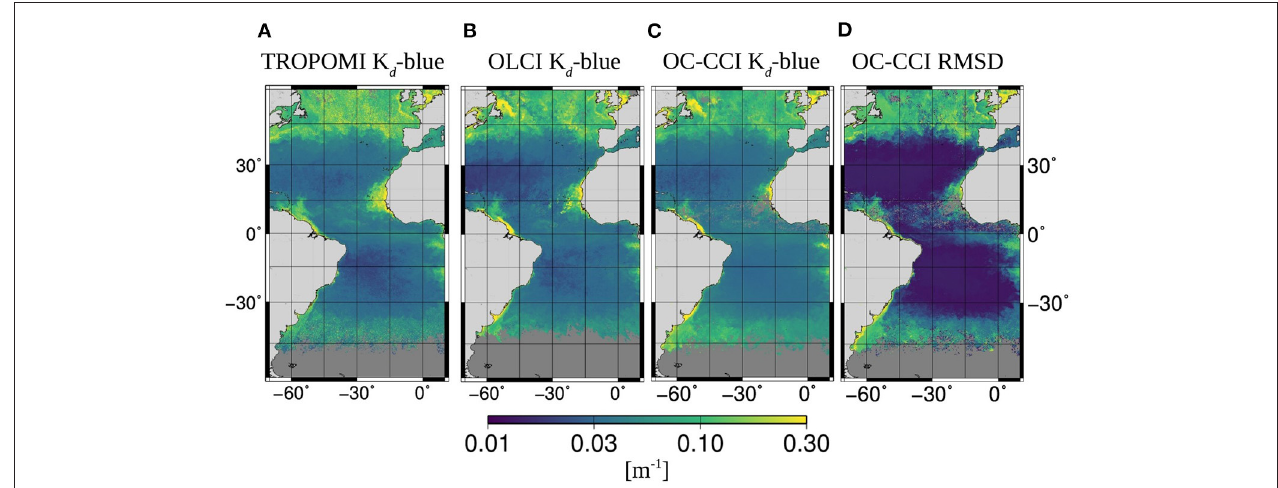
FIGURE 7 | (A) TROPOMI, (B) OLCI, and (C) OC-CCI K d -blue gridded at 0.083 ◦ as mean for 11 May to 9 June 2018. (D) RMSD provided in the OC-CCI product which was wavelength-converted to blue spectral range.